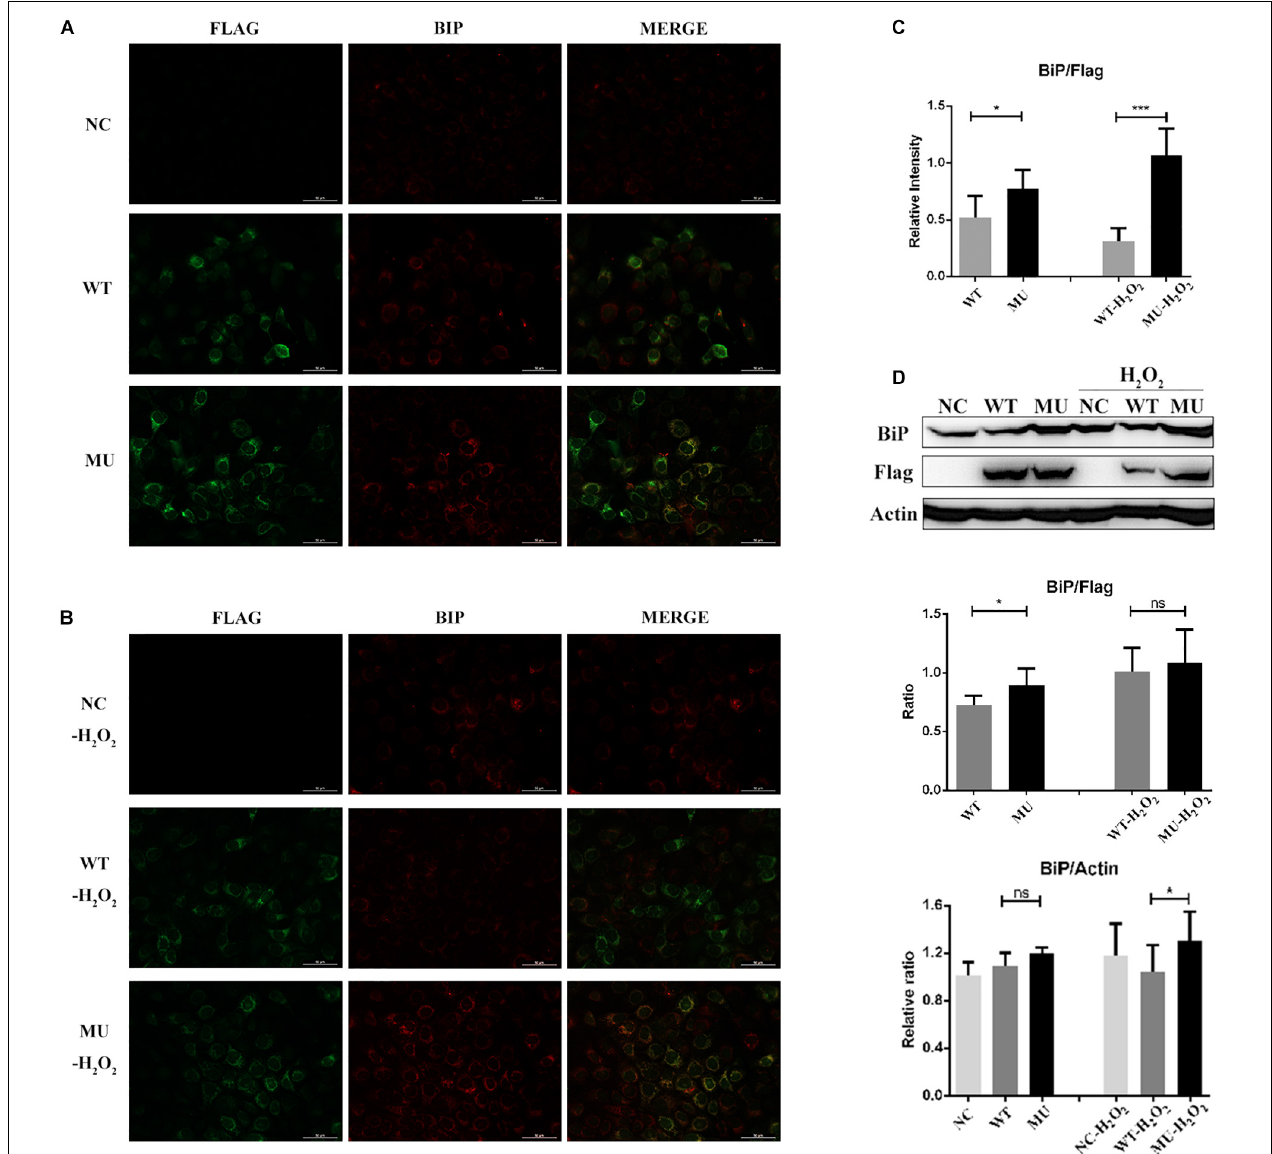
FIGURE 4 | Endoplasmic reticulum stress was enhanced in cells overexpressing mutant COL6A3 . (A) Immunofluorescence staining of BiP (red) as well as COL6A3 (green) proteins in un-transfected, WT, and MU cells under normal conditions. (B) Immunofluorescence staining of BiP (red) as well as COL6A3 (green) in un-transfected, WT, and MU cells upon 200 µ M of H 2 O 2 exposure for 1.5 h. (C) Column graph comparing the ratio of BiP/COL6A3 levels in FLAG-positive cells between WT and MU groups exposed or not exposed to 200 µ M of H 2 O 2 . Values were derived from immunofluorescence staining images. WT vs MU: P = 0.037; WT-H 2 O 2 vs MU-H 2 O 2 : P = 0.000003. The P -values were calculated by Student’s t-test for two group comparisons. (D) Western blotting for the detection of the BiP protein among un-transfected, WT, and MU HCECs exposed or not exposed to 200 µ M of H 2 O 2 . The quantitative graph displayed the ratio of BiP/beta-Actin levels of the three groups (based on the ratio of un-transfected group without H 2 O 2 exposure), and BiP/FLAG levels between WT and MU cells (BiP/FLAG, WT vs MU: P = 0.0198; BiP/Actin, WT-H 2 O 2 vs MU-H 2 O 2 : P = 0.0102). The P -values were calculated by Student’s t -test for two group comparisons. NC: the un-transfected HCECs. * P < 0.05, *** P <